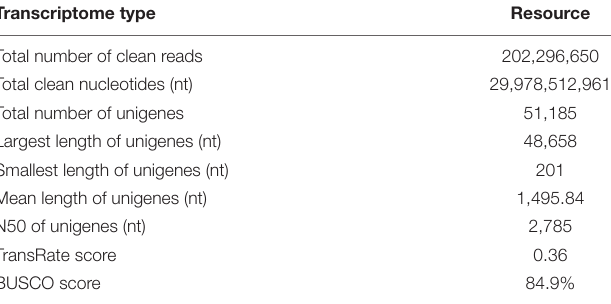
TABLE 2 | Summary of mixed-assembling of elongate loach.